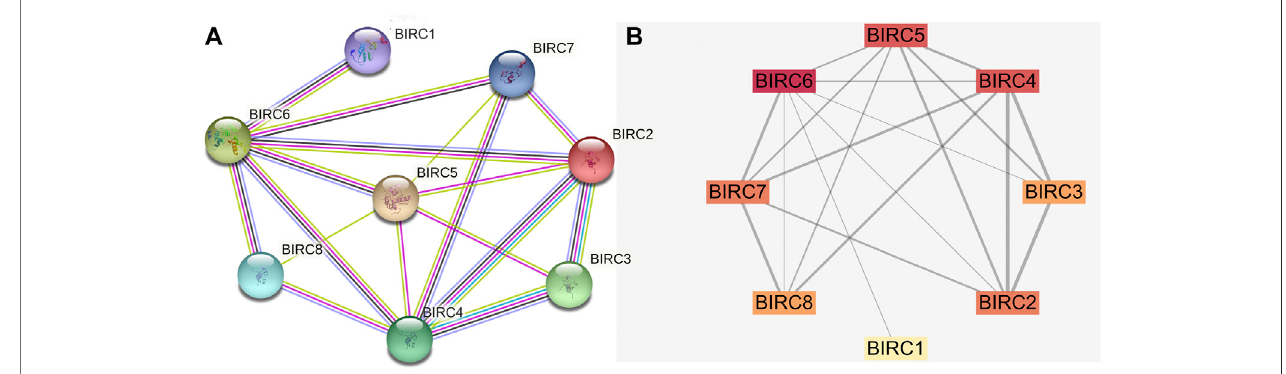
FIGURE 4 | Protein-protein interaction network of IAPs. (A) STRING analysis. Different colors of lines indicate a different source of evidence: light blue, curated databases; rose, experimentally determined; green, gene neighborhood; red, gene fusions; dark blue, gene co-occurrence; light green, text mining; black, co- expression; purple, protein homology. (B) Cytoscape analysis. The darker the color, the greater the degree; the wider the line, the stronger the interaction.